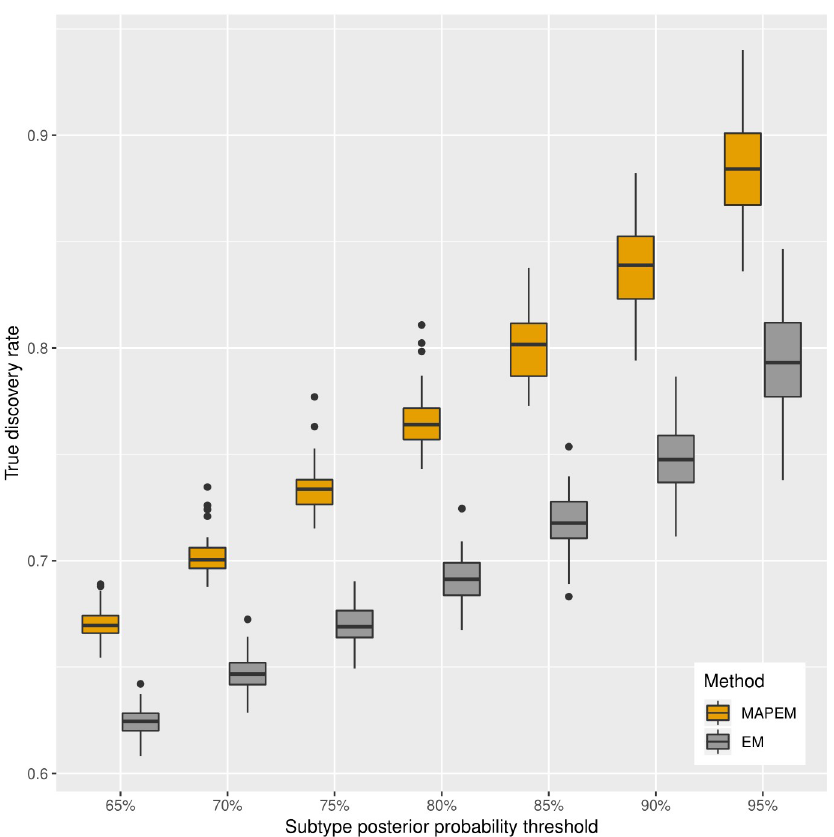
Fig 4. Comparison between the true discovery rate (TDR) of classifying tissue-specific subtypes by the MAP-EM algorithm (under the Bayesian framework of the mixture model which eGST employs) versus the EM algorithm (under the frequentist framework of the mixture model) based on the threshold of tissue-specific subtype posterior probability as 65%, 70%, 75%, 80%, 85%, 90%, 95%, respectively. Box plots of TDR across 50 datasets simulated under h 2 ¼ h 2 ¼ 10% , w ¼ w ¼ 1 , m 1 = m 2 = 1000, n = 40, 000 are presented. Here h 2 1 2 1 2 2 heritability of tissue-specific subtypes of the trait due to m 1 and m 2 SNPs representing two sets of tissue-specific eQTL SNPs, w 1 and w 2 are the proportions of individuals in the sample assigned to the two tissues, n is the total number of